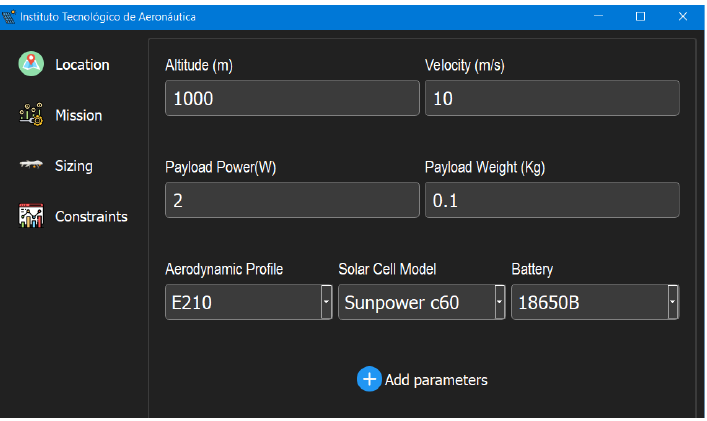
Figure 17. Fields for the mission parameters.